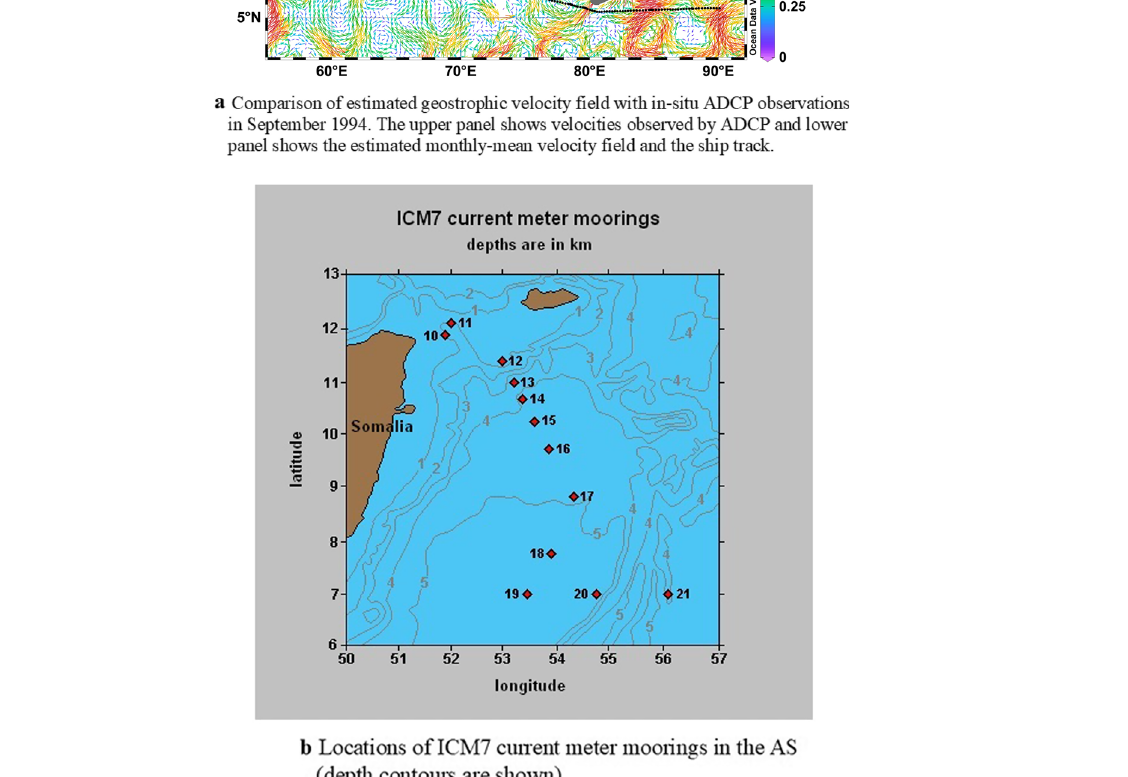
Fig. 5 a Comparison of estimated geostrophic velocity field with in-situ ADCP observations in September 1994. The upper panel shows velocities observed by ADCP and lower panel shows the estimated monthly-mean velocity field and the ship track. b Locations of ICM7 current meter moorings in the AS (depth contours are shown). c Comparison of estimated monthly-mean geostrophic velocity components (abscissa) with ICM7 current meter data (ordinate). The upper panel shows the zonal component and lower panel, the meridional component (m/s). d Time series of monthly-means of estimated and observed velocity components at IK-19. The right and left panels show zonal and meridional components,